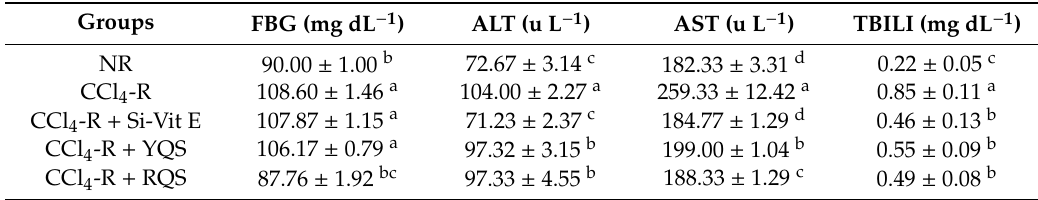
Table 4. E ff ect of quinoa extracts on FBG, ALT, AST, and TBILI of rats with CCl 4 -induced oxidative stress (mean ± SE), n =